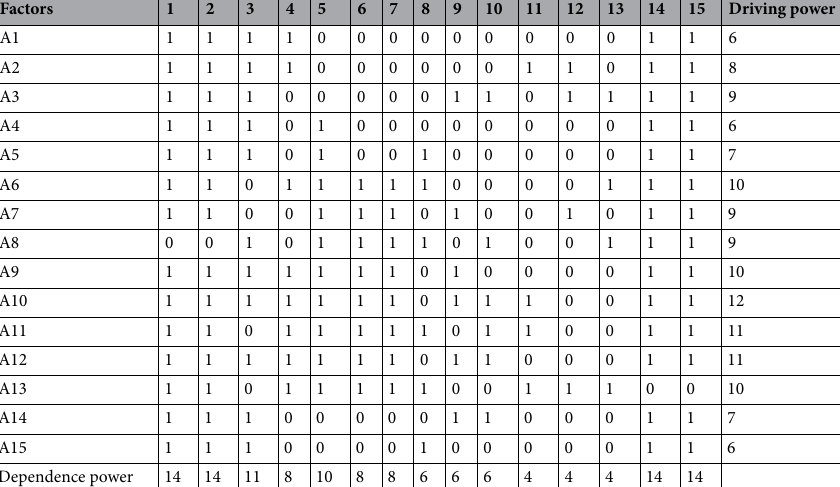
Table 4. Matrix of final